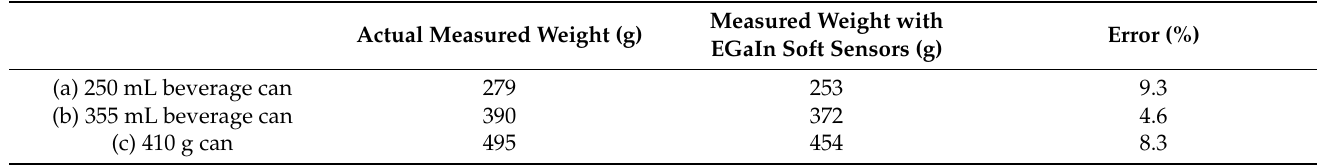
Table 9. Comparison of sensor-estimated measurements and actual weight values for gripping